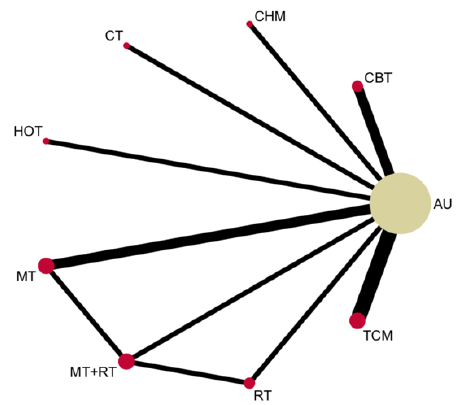
Figure 2. Network plot for each intervention. The size of the nodes is proportional to the sample size of each intervention and the thickness of the lines proportional to the number of trails available. AU = treatment, nursing, rehabilitation, education as usual; CBT = cognitive behavioral therapy; CHM = community health management; CT = circuit training; HOT = hyperbaric oxygen therapy; MT = music therapy; RT = respiratory training; TCM = traditional Chinese medicine.